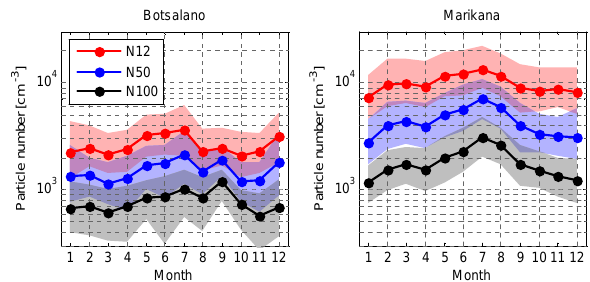
Fig. 8. Monthly median concentrations of N 12, N 50 and N 100 for Botsalano and Marikana. Shaded areas indicate the upper and lower quartiles.